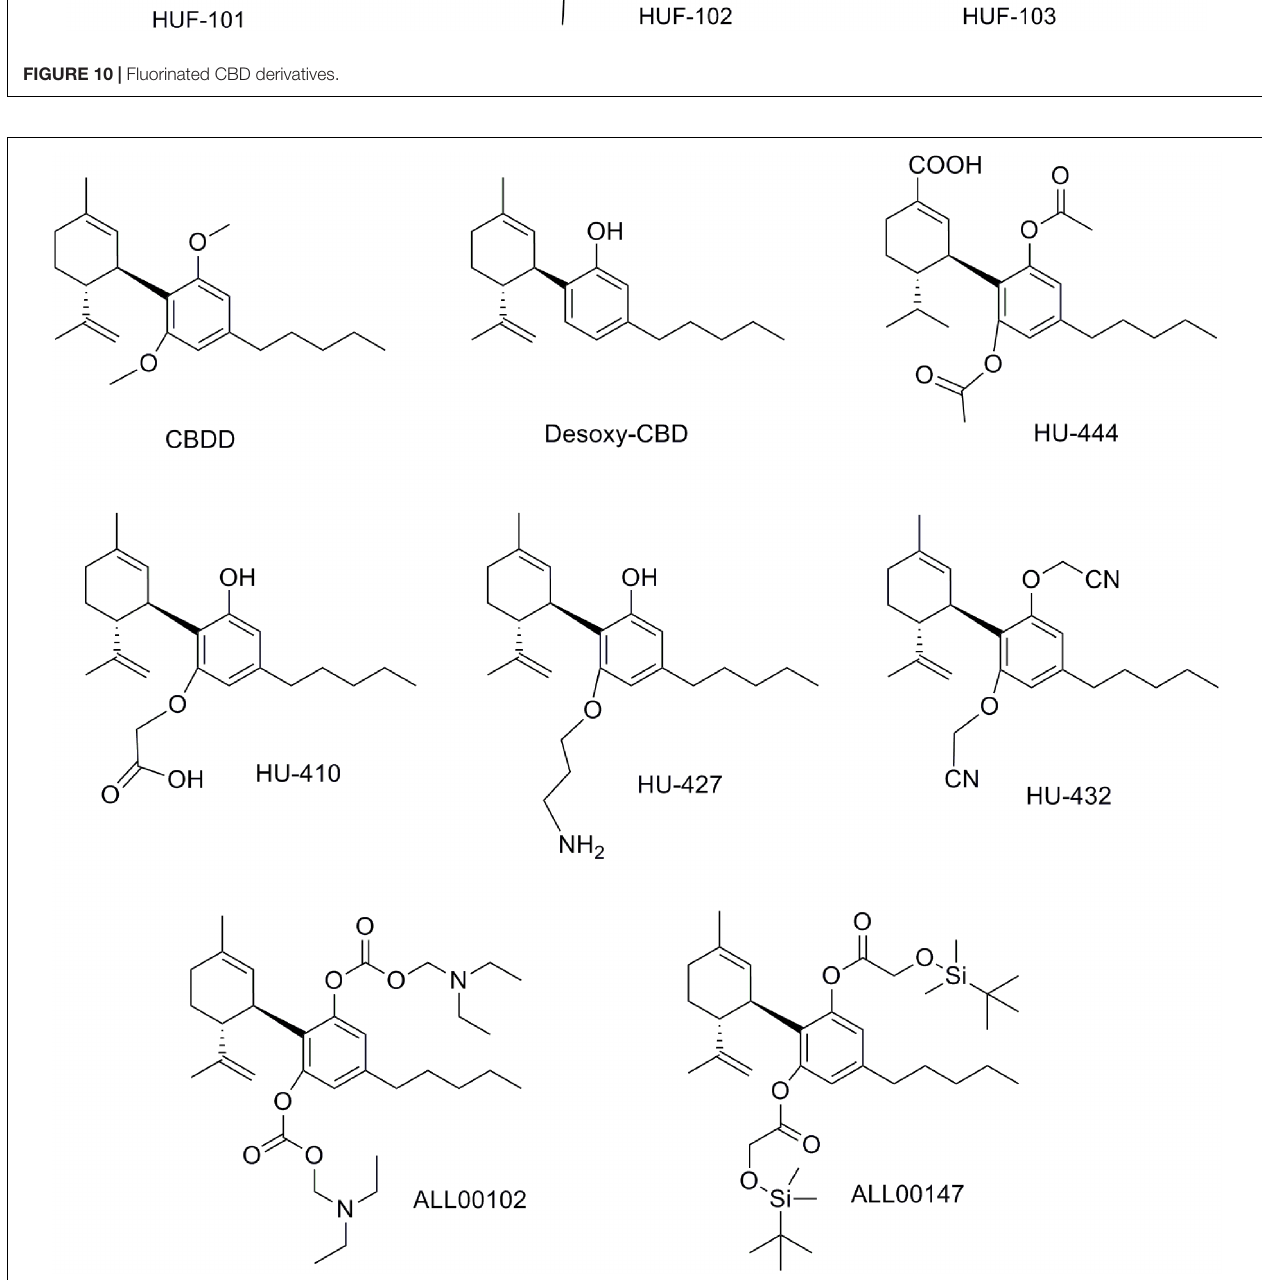
FIGURE 11 | Cannabidiol derivatives modified at the hydroxyl